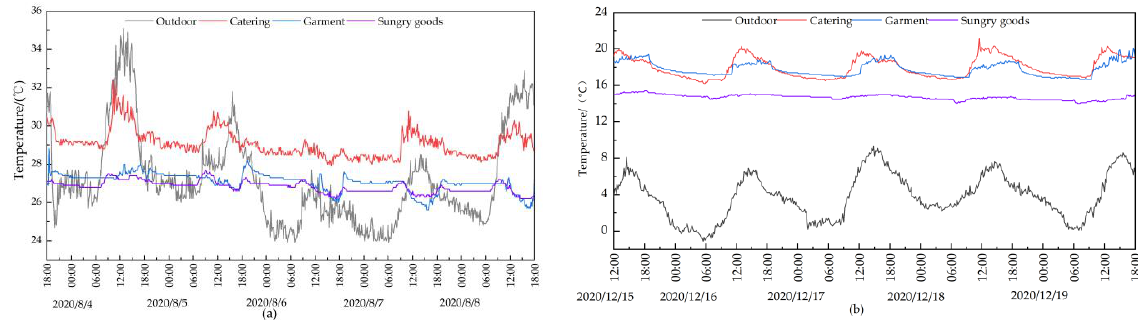
Figure 3. Variation of air temperature in summer ( a ), and winter ( b ).